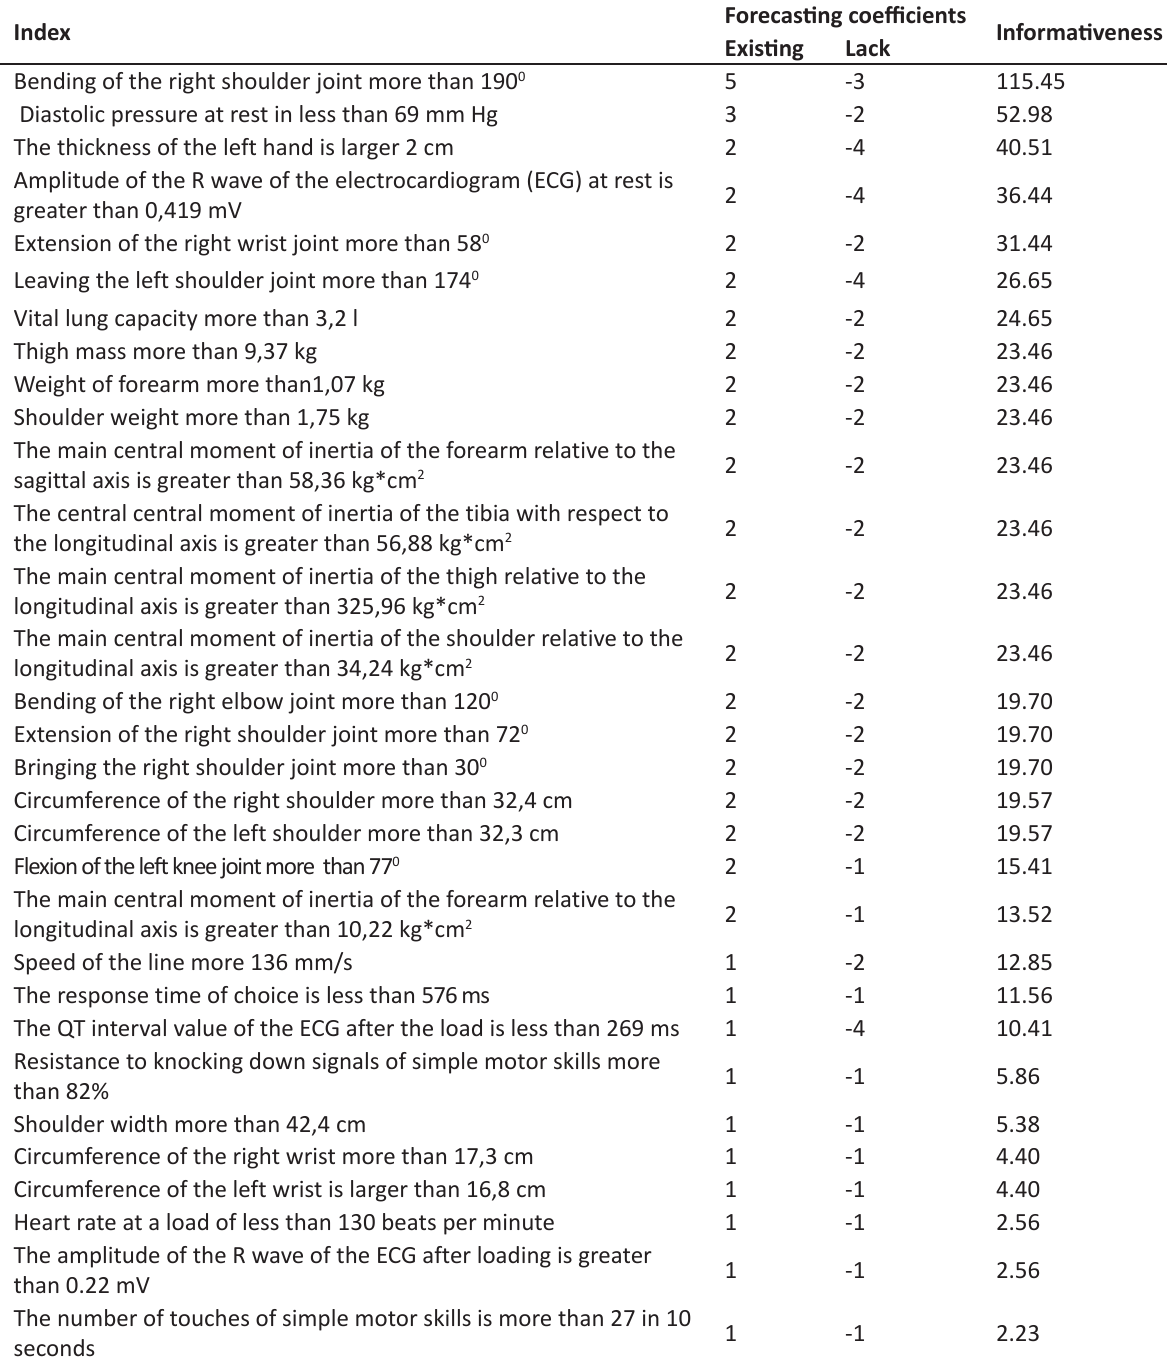
Table 1. Forecasting the success of kickboxing